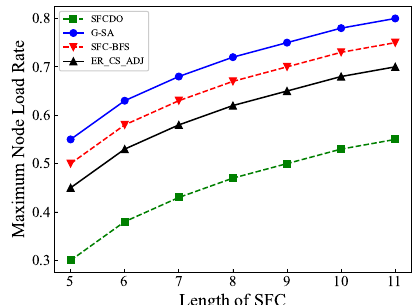
Figure 10. Maximum node load rate of SFCs in large